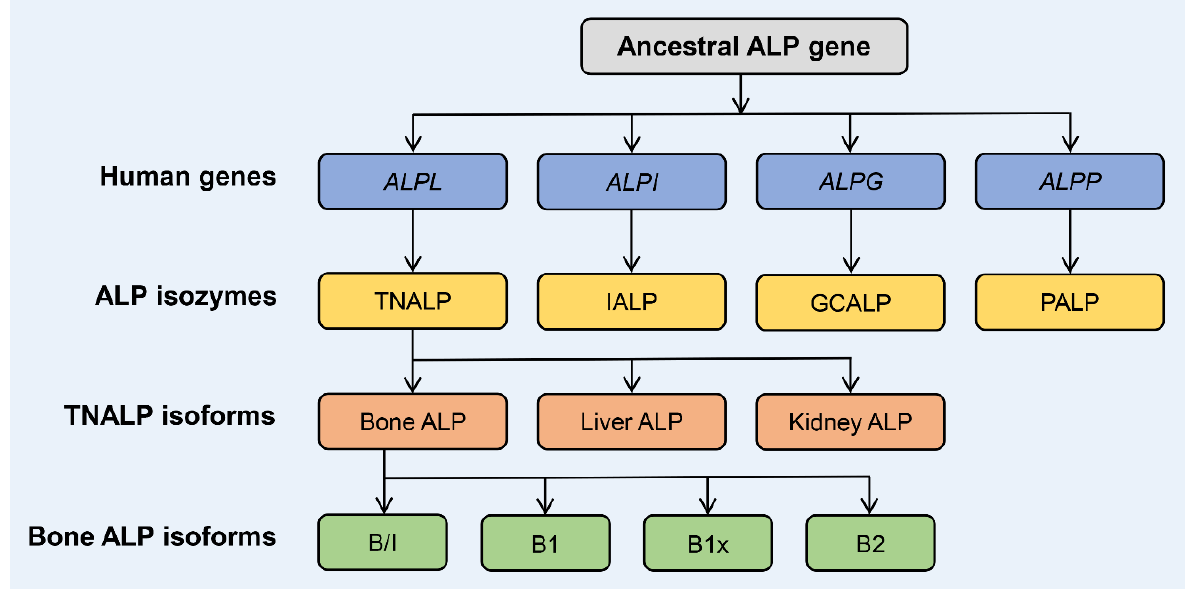
Figure 1. Four ALP isozymes are expressed in humans: tissue-nonspecific ALP (TNALP), intestinal ALP (IALP), germ cell ALP (GCALP), and placental ALP (PALP). The highest levels of human TNALP isoforms are expressed in bone, liver, and kidney tissues. Four BALP isoforms (B/I, B1x, B1, and B2) can be detected and quantified by weak anion-exchange high-performance liquid chroma- tography. The three BALP isoforms B/I, B1, and B2 are all detected in serum from healthy individ- uals. It should be noted that the B/I (bone/intestinal) ALP isoform is not a pure BALP isoform be- cause it co-elutes with circulating IALP (approximately 70% BALP and 30% IALP) and comprises only approximately 6% of the total serum BALP activity. The fourth BALP isoform, B1x, is present in extracts of human bone tissue and exclusively in the serum of patients with different stages of CKD.